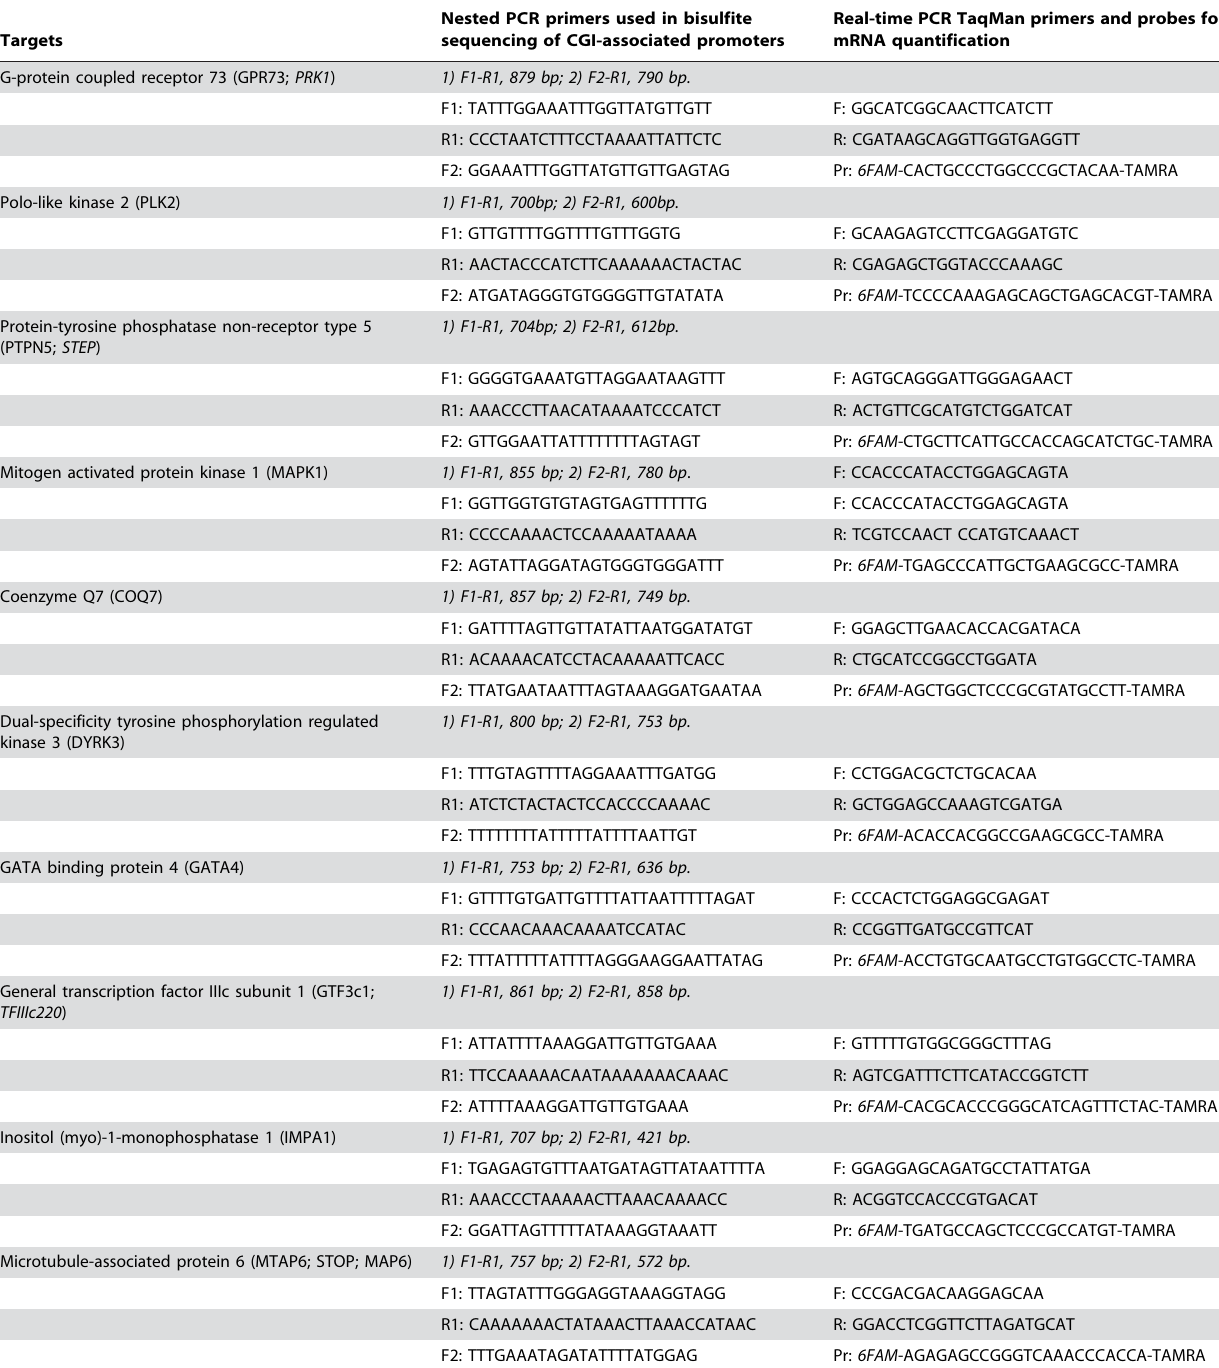
Table 3 . Primers and probes used in bisulfite sequencing and for real-time PCR.